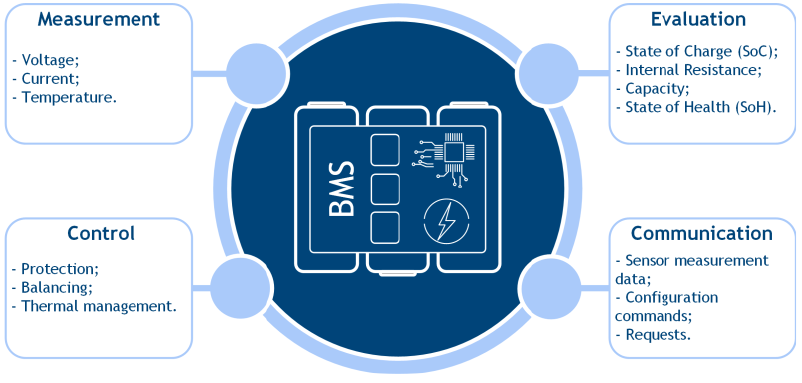
Figure 1. Functions of a BMS.